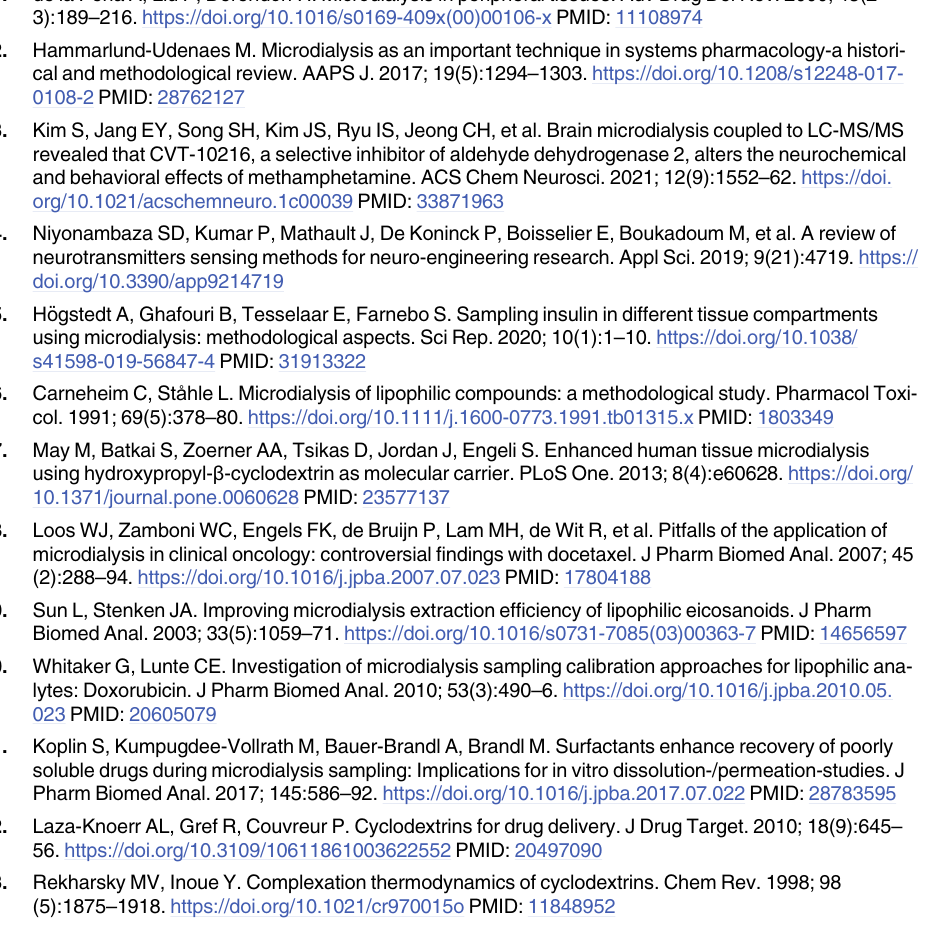
S1 Table. The original RR and RR of doxorubicin, risperidone, temozolomide, and M U albumin-bound paclitaxel when using different types of cyclodextrins as